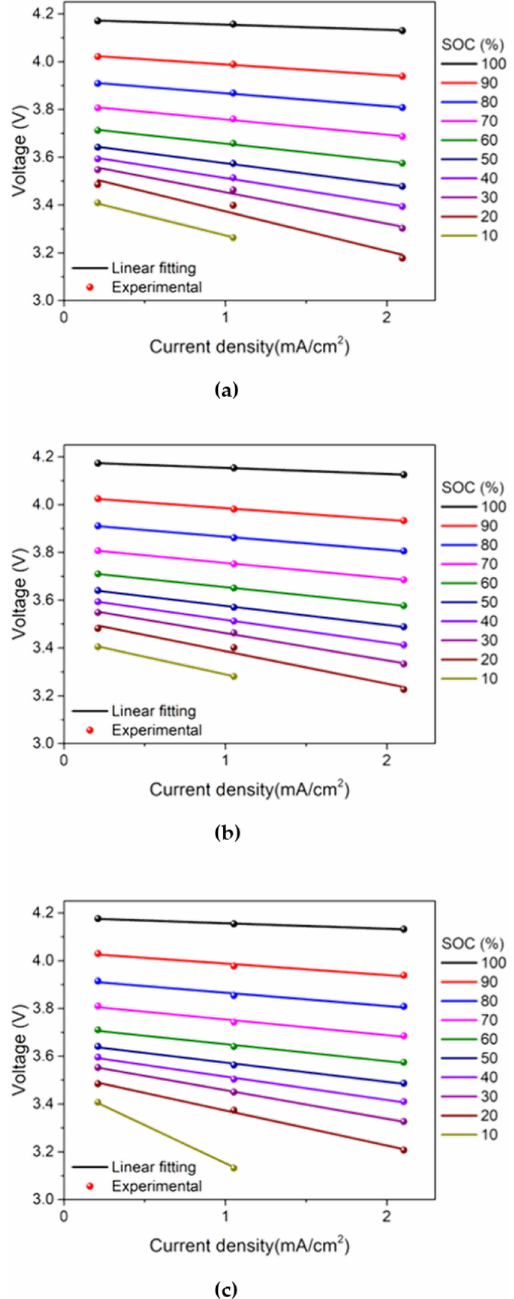
Figure 3. Cell voltage based on discharge-current density without cyclable lithium loss and with three levels of electrolyte depletion: ( a ) cell 1; ( b ) cell 2; and ( c ) cell 3. The discharge capacity of the LIB cell was estimated by using U and Y calculated for cyclable lithium losses ranging from 0 to 30% and an electrolyte volume ranging from 5 to 20 µ L. The capacity at the discharge rate of 0.05 C was calculated by using the above-mentioned model and the parameters of U and Y , and it was compared with the experimental results in Figure 7. The 0.05 C discharge capacity is 166 mAh/g with no cyclable lithium loss and no electrolyte depletion. When there is no cyclable lithium loss, the 50% of electrolyte depletion brings about 5% reduction. On the other hand, the cyclable lithium loss of 30% coupled with 50% of electrolyte depletion results in 46% reduction. As the amount of cyclable lithium loss and electrolyte depletion increases, the decrease in capacity becomes more